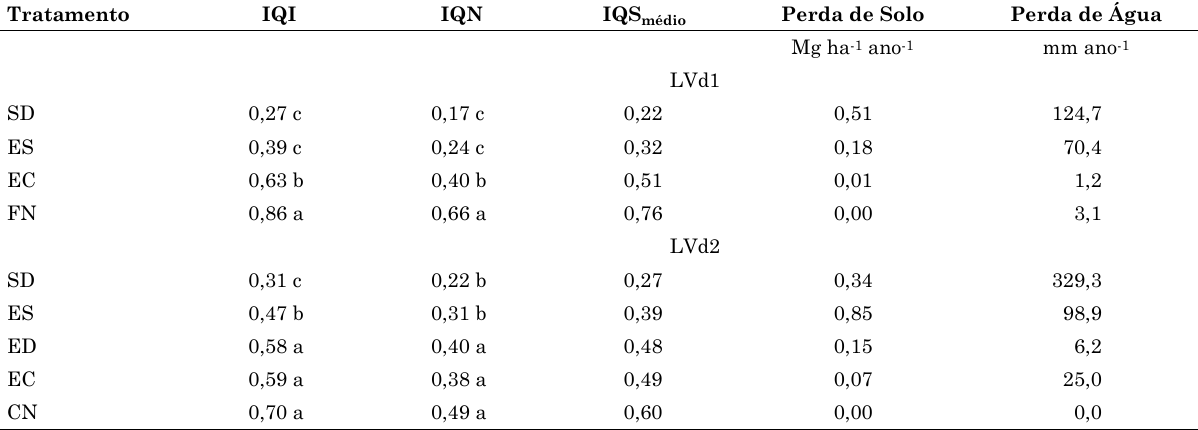
Figura 3. Relações lineares entre a erosão hídrica (perdas de solo e de água) e o índice de qualidade do solo.